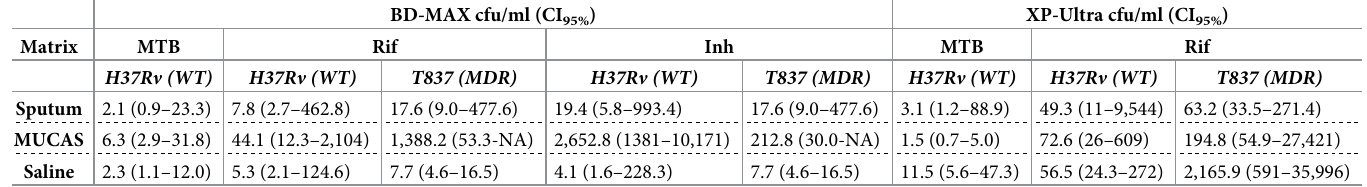
Table 1. Analytical sensitivity for the detecting genetic resistance markers of Inh (H) and Rif (R) reported as LoD95HR of BD-MAX and XP-Ultra determined by mathematical